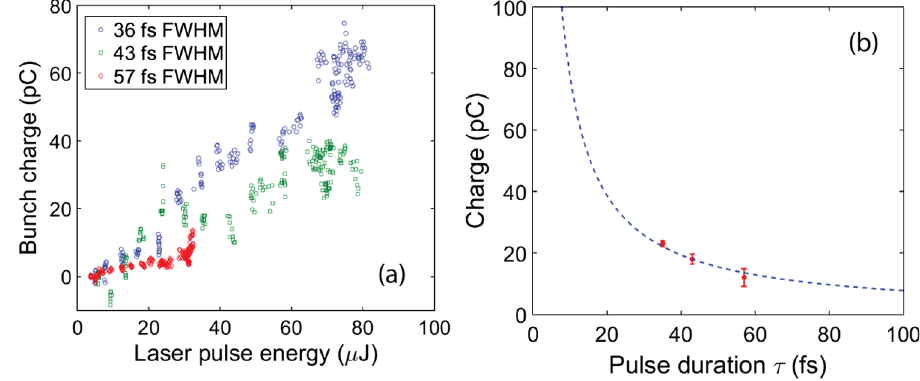
FIG. 5. Laser pulse duration and electron bunch charge. (a) Absorbed laser pulse energy E(1-R) vs electron bunch charge at different pulse duration. (b) Laser pulse duration vs electron bunch charge at 30 μ J laser pulse energy, the dashed line is the fit of 1 = τ , the error bars are calculated from Fig. 5(a).